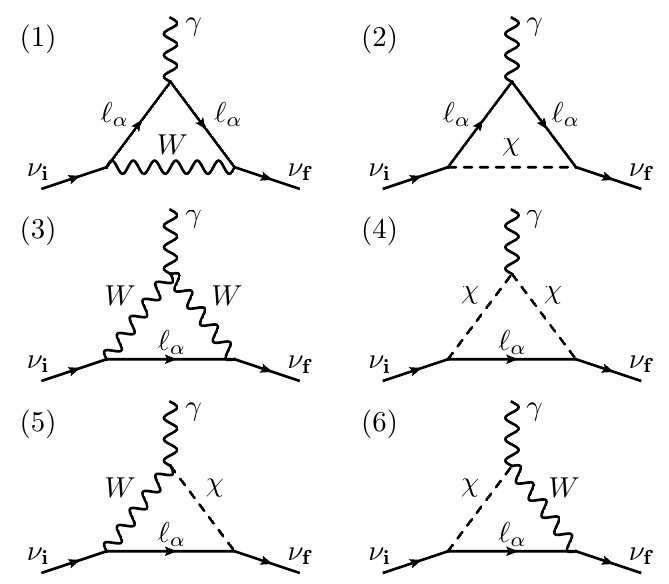
Figure 1 . All Feynman diagrams contributing to the neutrino electromagnetic transition dipole moment, where χ is the charged Goldstone